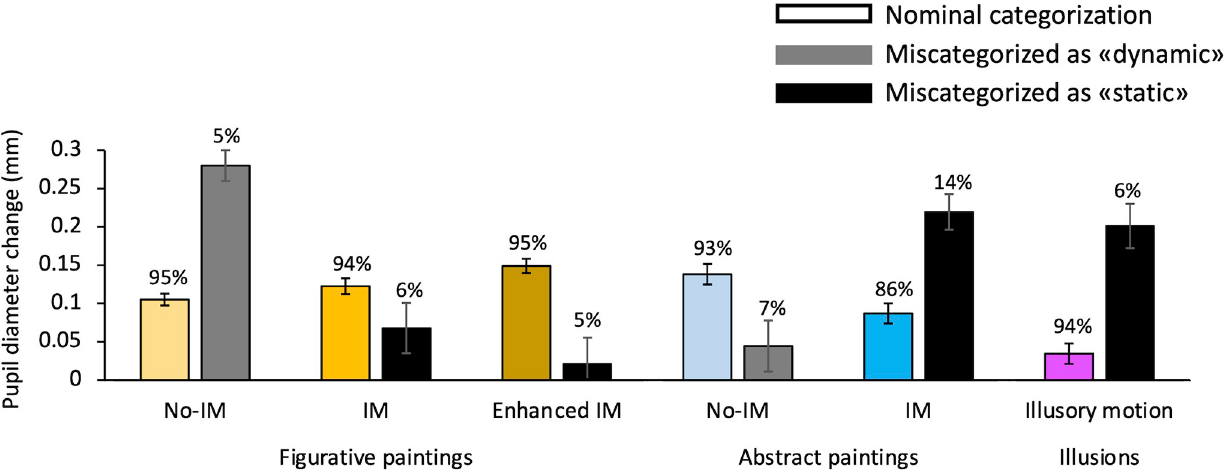
Fig 4. Effects of motion interpretation on pupil size. Mean pupillary diameter for paintings/illusions correctly categorized in accordance with our nominal categorization (colored bars with color-code used in Figs 2 and 3) versus miscategorized stimuli (gray bars: Images rated as dynamic; black bars: Images rated as static). Data of miscategorized paintings/illusions are those excluded from the analysis of pupil responses to each category. Errors bars are SE. Percentages of correct categorization/miscategorization of dynamism for each stimulus category are reported over each bar.